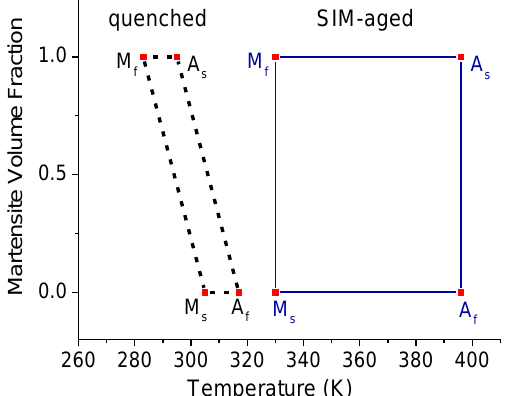
Figure 9. Schematic hysteresis loops from the start and finish temperatures published in [11].